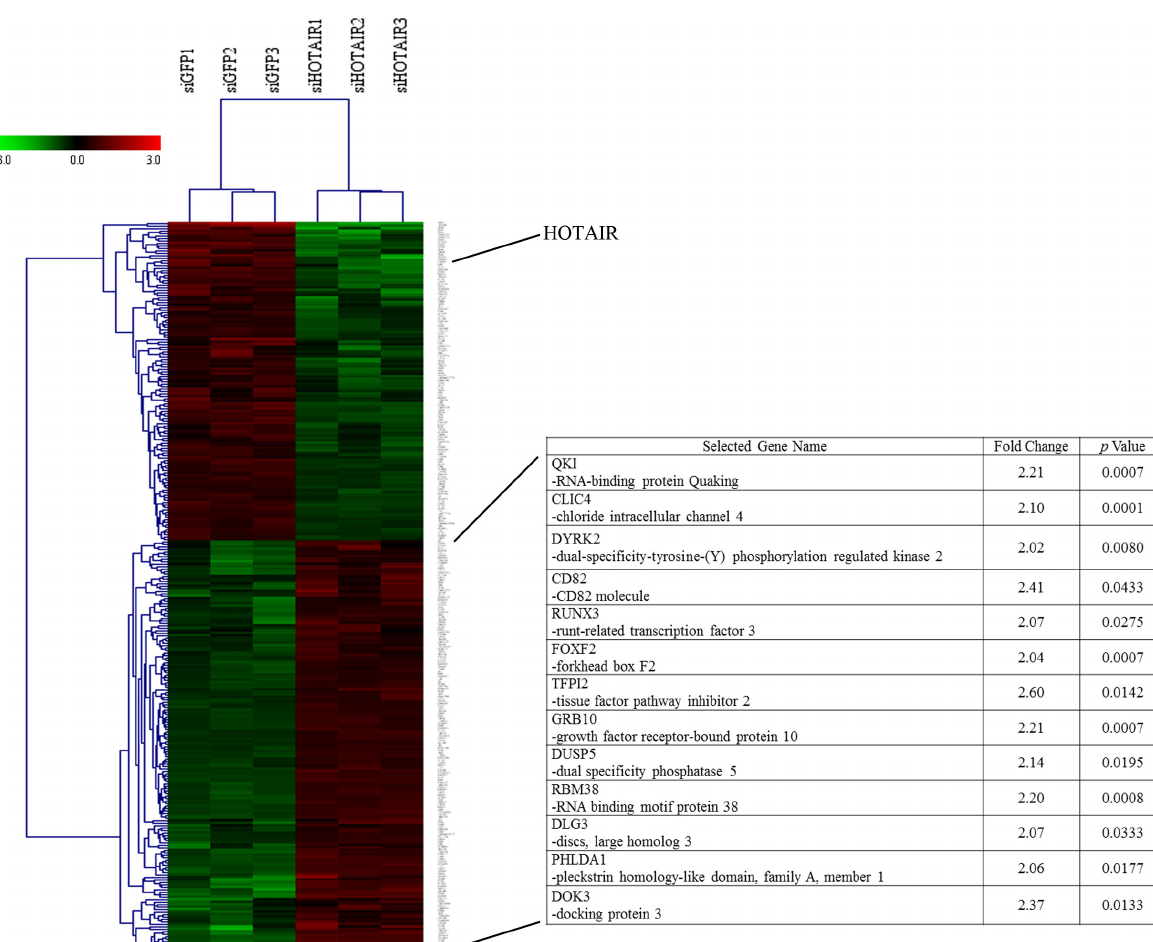
Figure 1. Global transcriptional changes by microarray analysis of HOTAIR loss in Bel-7402 HCC cell line. ( Left ), Heat map depicting transcript profiling of independent biologic replicate Bel-7402 cells with siRNA-mediated HOTAIR depletion (siHOTAIR) versus control siRNA (siGFP). Red represents upregulated genes while green represents downregulated genes; ( Right ), selected genes for further